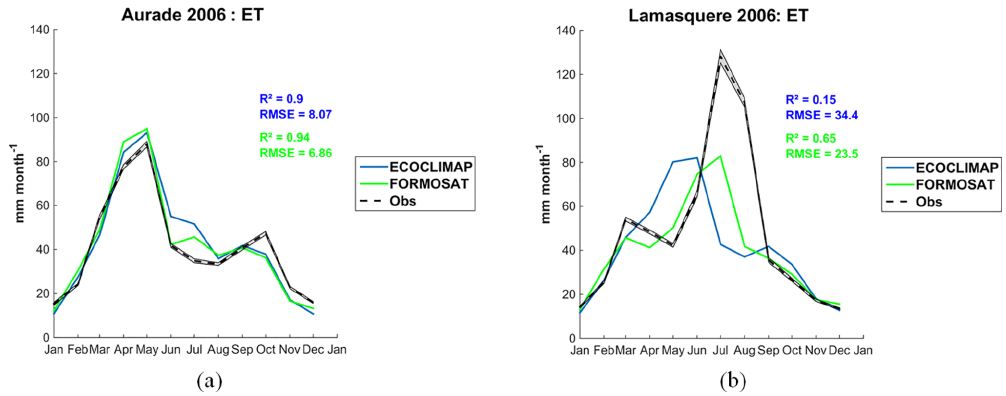
Figure 4. Evapotranspiration time series for Auradé (a) and Lamasquère (b) for 2006. The gray filled areas represent the standard deviations for the measured time